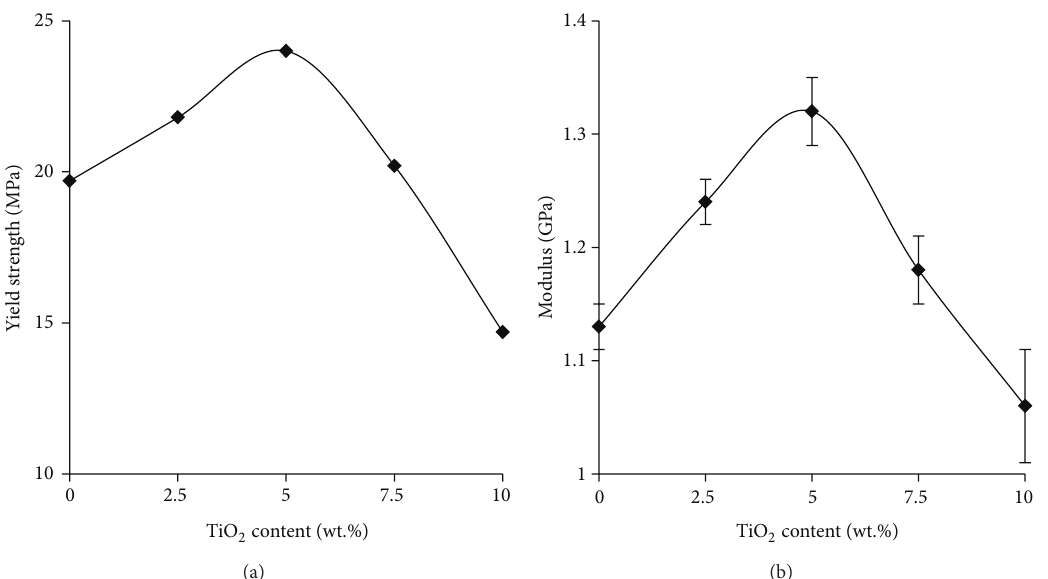
Figure 7: Mechanical properties of epoxy-titania composites as a function of the concentration of titania